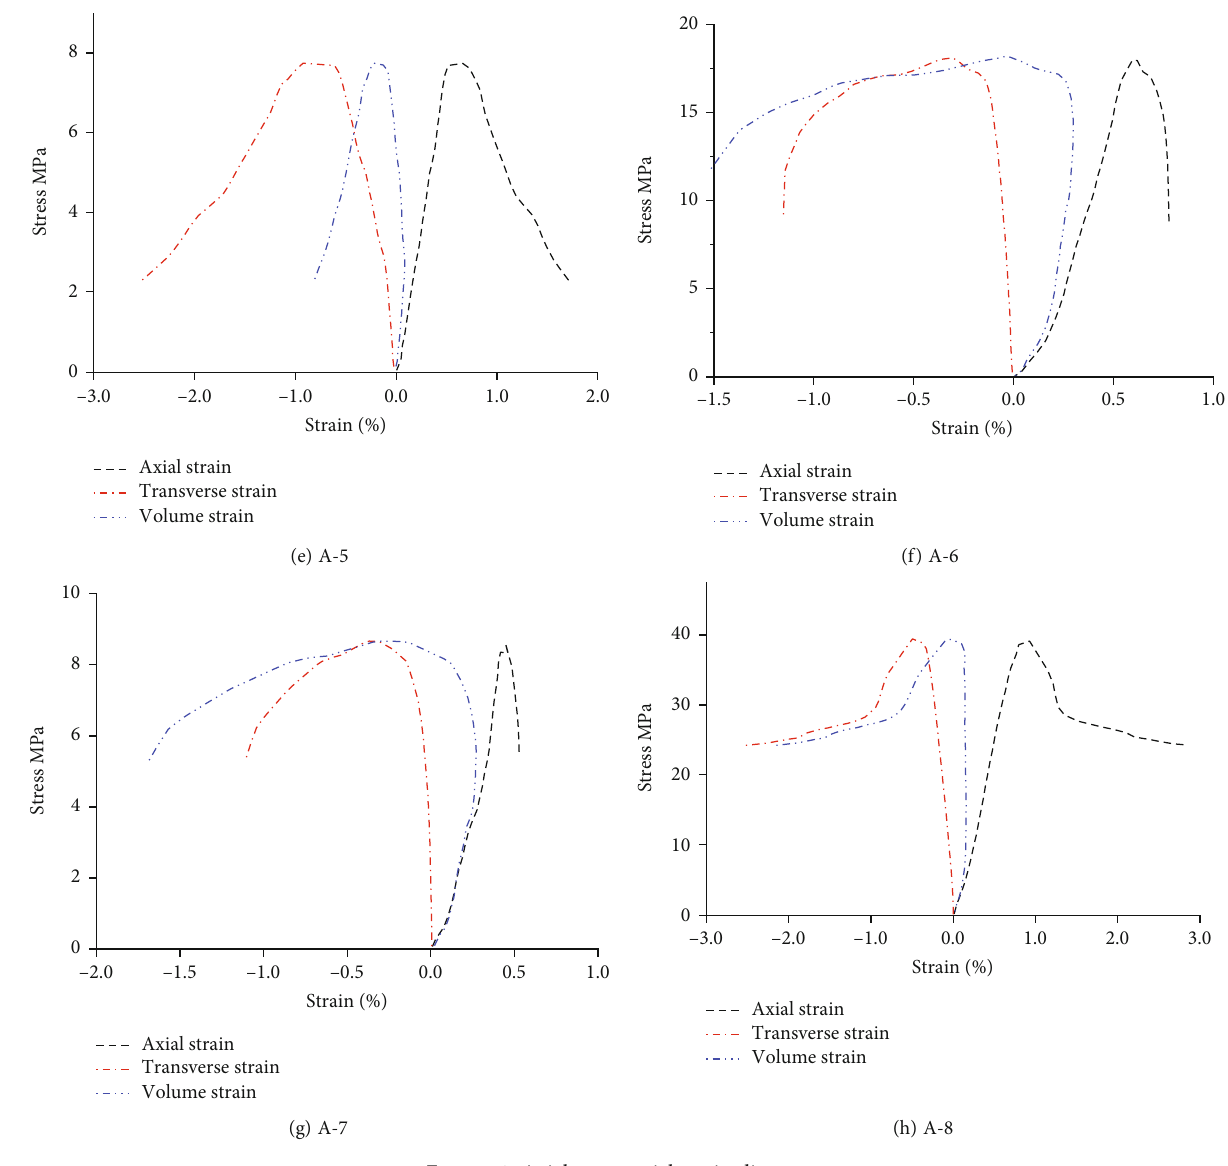
Figure 1: Axial stress-axial strain